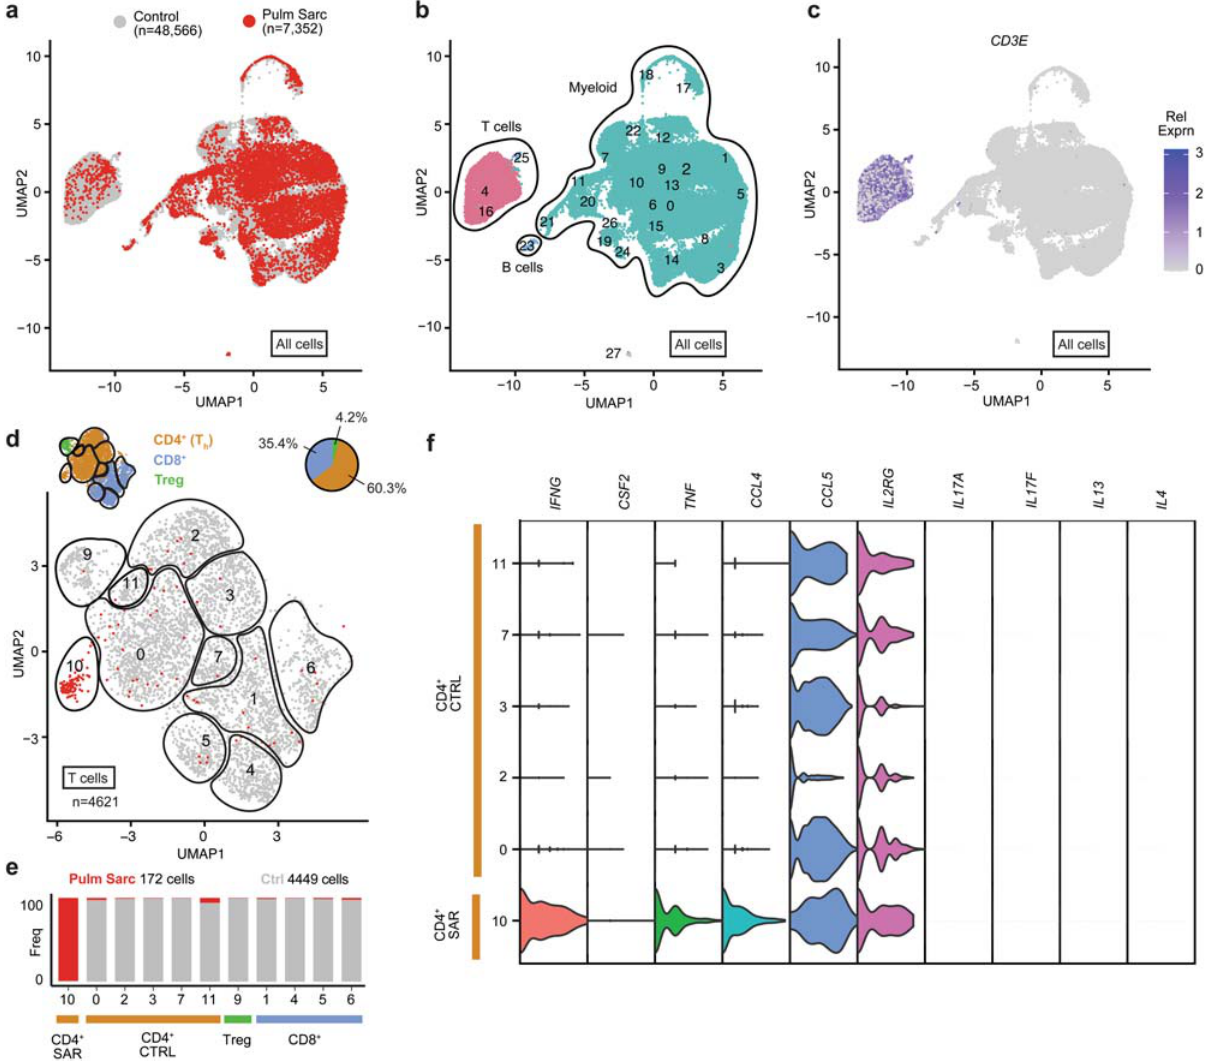
Fig. 5 Analysis of scRNAseq data of bronchoalveolar lavage (BAL). Patients with sarcoidosis ( n = 4) 29 and healthy control patients ( n = 10) 30 were included. a UMAP projection of scRNA-seq data of all cells colored by condition (red: sarcoidosis libraries, grey: control libraries). b UMAP projection of scRNA-seq data of all cells colored by cell type. c UMAP projection of scRNAseq data of all cells showing relative CD3E expression. d UMAP projection of scRNAseq data of T cell clusters colored by condition (red: sarcoidosis libraries, grey: control libraries). e Histogram showing the contribution of each condition (sarcoidosis: red, grey: controls) to each T cell cluster. f Violin plots showing expression of select genes in each cluster of CD4 + FOXP3 - cluster of T